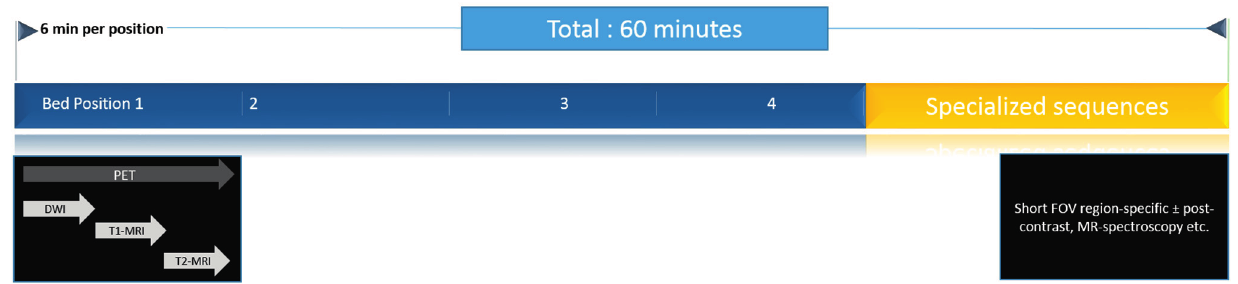
Figure 2. A typical PET/MRI workflow, as performed in our institution. Patients are scanned in four bed positions to cover the anatomy from head to mid-thighs. Whole body imaging is lasts for 60